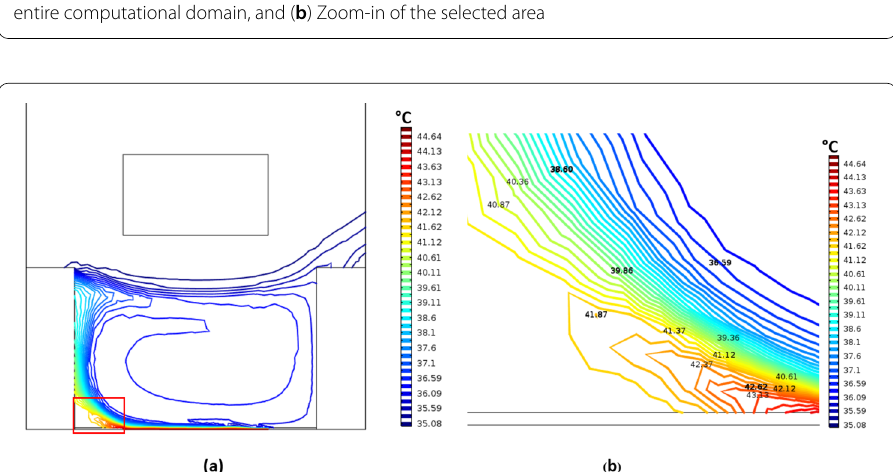
Figure 9 The temperature contour ( ° C) at steady state when u = 25 km/h (strong wind): ( a ) Half of the entire computational domain, and ( b ) Zoom-in of the selected